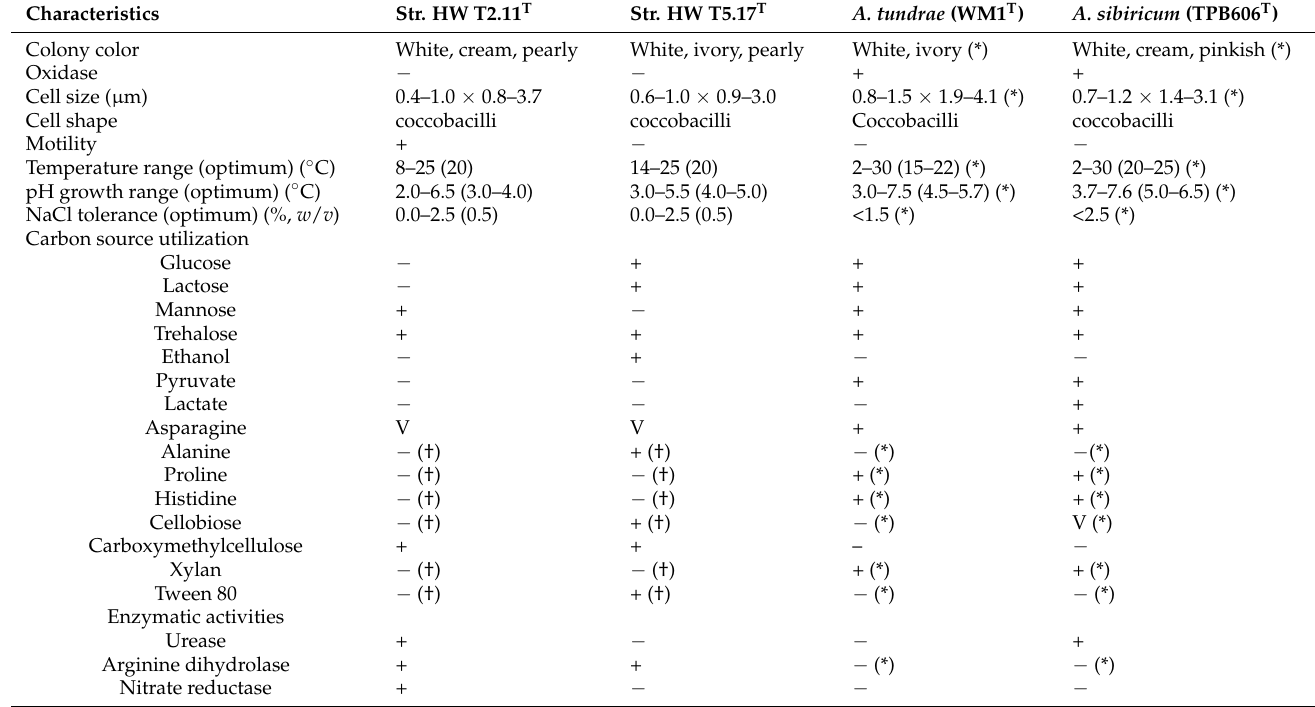
Table 1. Characteristics differentiating strains HW T2.11 T ( Acidisoma silvae ) and HW T5.17 T ( A. cellulosilytica ) from other species of the genus Acidisoma . Characteristics are scored as: +, positive; − , negative; V, variable. The four strains utilized sorbitol, inositol, sucrose, glycerol, yeast extract and casamino acids. None of the strains was able to utilize lactose (fermentative), glucose (fermentative), maltose, mannitol, benzoate, citrate, butyrate, and gelatin. They were all capable of hydrolyzing starch, fucoidan, laminarin, and pectin. Characteristics Colony color